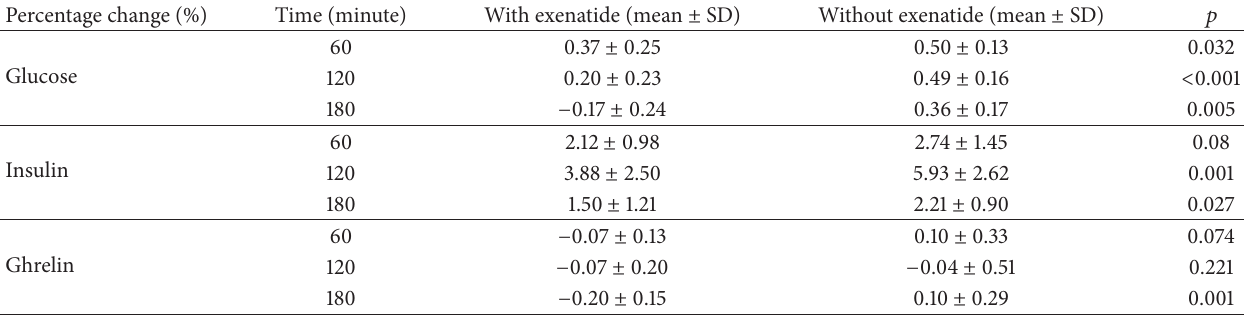
Table 3: Percentage changes in serum glucose, insulin, and ghrelin levels at 60, 120, and 180 minutes following mixed meal test with and without exenatide